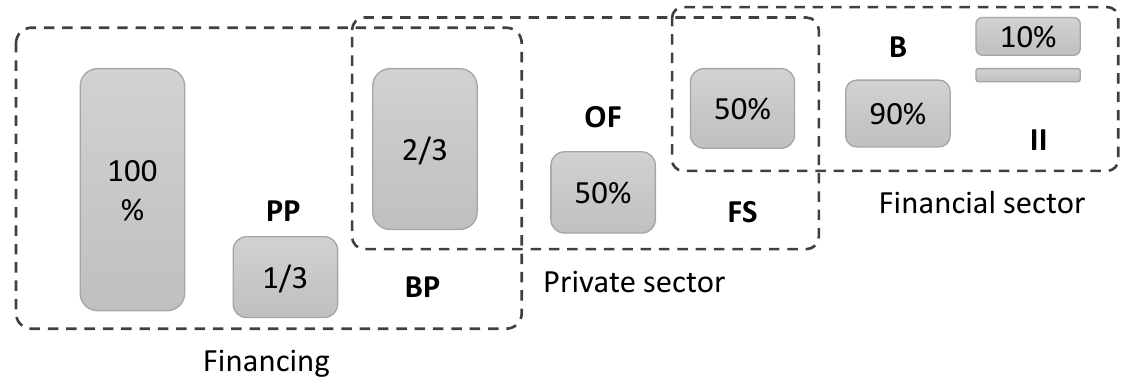
Figure 2. Model for financing of energy efficiency projects in the framework of PPP or MPP under the direct